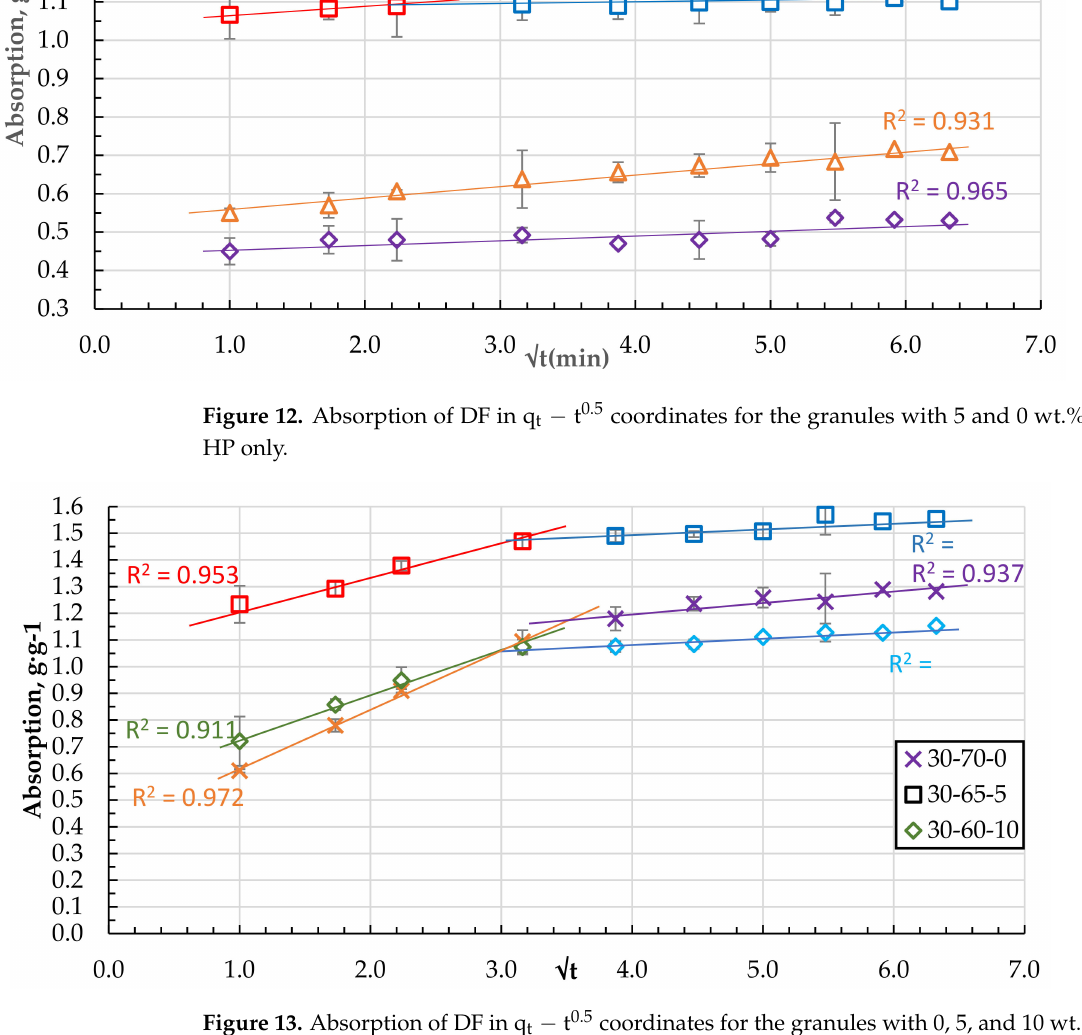
Figure 13. Absorption of DF in q t − t 0.5 coordinates for the granules with 0, 5, and 10 wt.% of